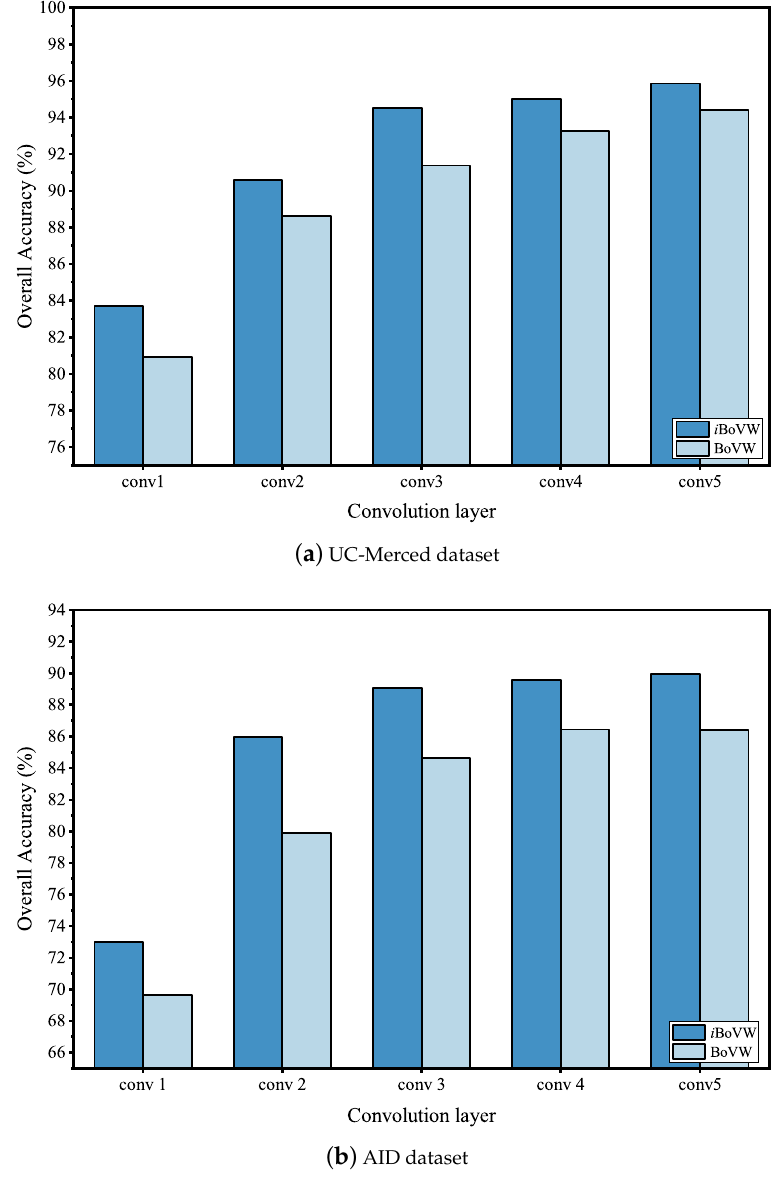
Figure 8. OAs with respect to different sizes of visual vocabulary on two public